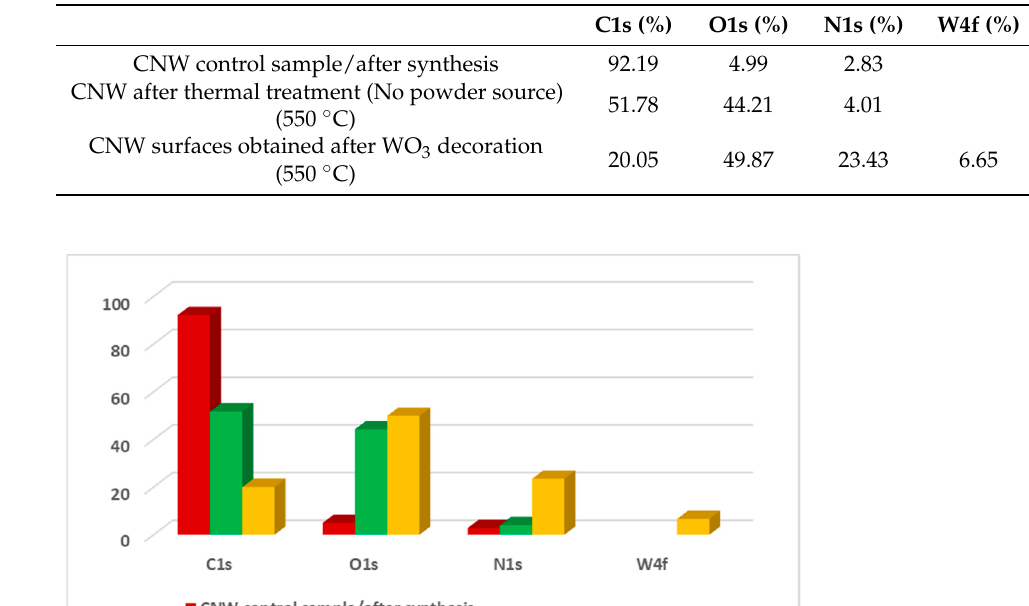
Table 2. The atomic concentration of the obtained hybrid nanostructures in plasma on conditions.